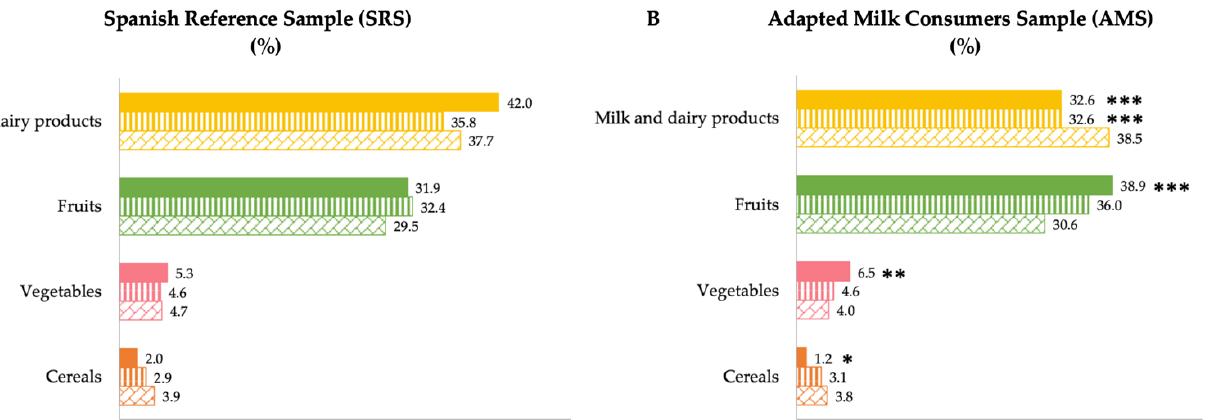
Figure 2. Dietary food and beverage groups contributing to intrinsic sugar intakes (%) from the EsNuPI study population (“Spanish Pediatric Population”) in both the Spanish Reference Sample ( A ) and the Adapted Milk Consumers Sample ( B ) by age group. * p ≤ 0.05 compared to reference sample (Mann–Whitney test); ** p ≤ 0.01 compared to reference sample (Mann–Whitney test); *** p ≤ 0.001 compared to reference sample (Mann–Whitney test). Only foods contributing ≥ 1% to total intrinsic sugar intakes of the population have been included.